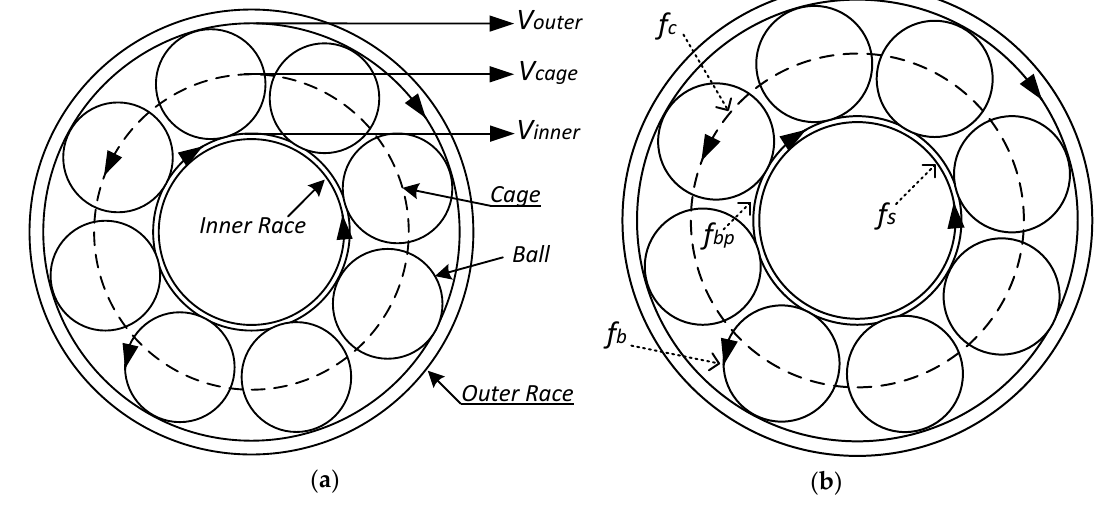
Figure 1. Bearing geometry showing ( a ) bearing velocities ( b ) bearing frequencies. The cage of the bearing moves with the balls. The cage frequency could be calculated through linear velocity of the cage. The linear velocity of the cage ( 𝑉 𝑐𝑎𝑔𝑒 ) is mean of outer race and inner race linear velocities. The cage frequency ( 𝑓 𝑐𝑎𝑔𝑒 ) is obtained by dividing the cage velocity with the radius of the cage [47].